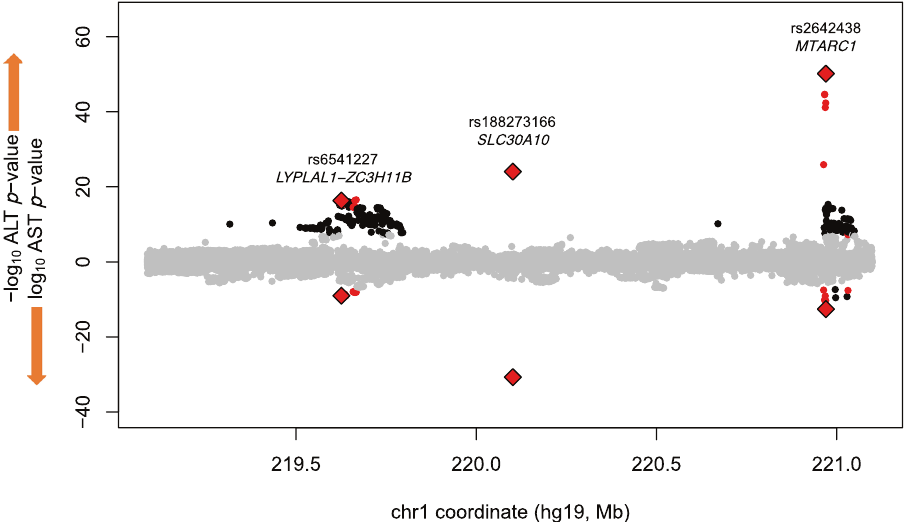
Fig. 4 Miami plot of trans-ancestry SAIGE GWAS results within 1 Mb of the gene body of SLC30A10 . ALT associations are shown in the positive direction and AST associations in the negative direction. Variant associations reaching genome-wide signi fi cance for one enzyme are colored black; for both enzymes, colored red; directly-genotyped variants signi fi cant for both enzymes, red diamonds. Source data for this fi gure are available from NHGRI- EBI GWAS catalog accession GCST90013663 and